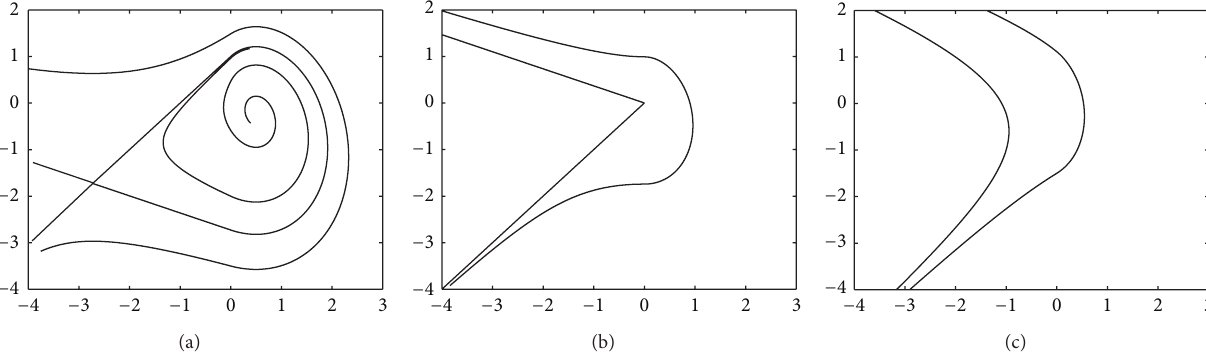
Figure 9: Discontinuity induced homoclinic bifurcation in the nondegenerate